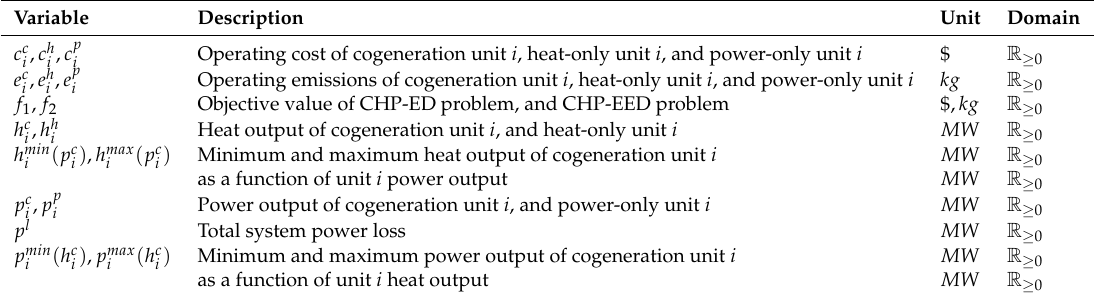
Table 3. Variables used for modeling CHP dispatch. R ≥ 0 is the set of all nonnegative real numbers.